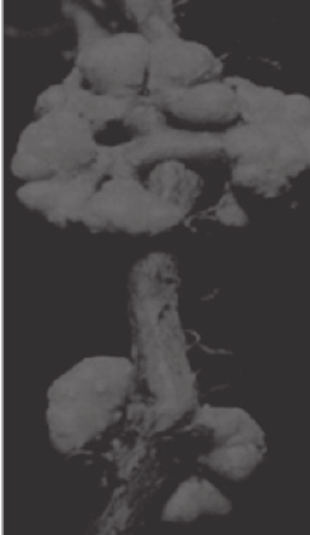
Figura 3. Foto de raiz de leguminosa com nódulos não muito nítidos, encontrada em um dos livros didáticos analisados.